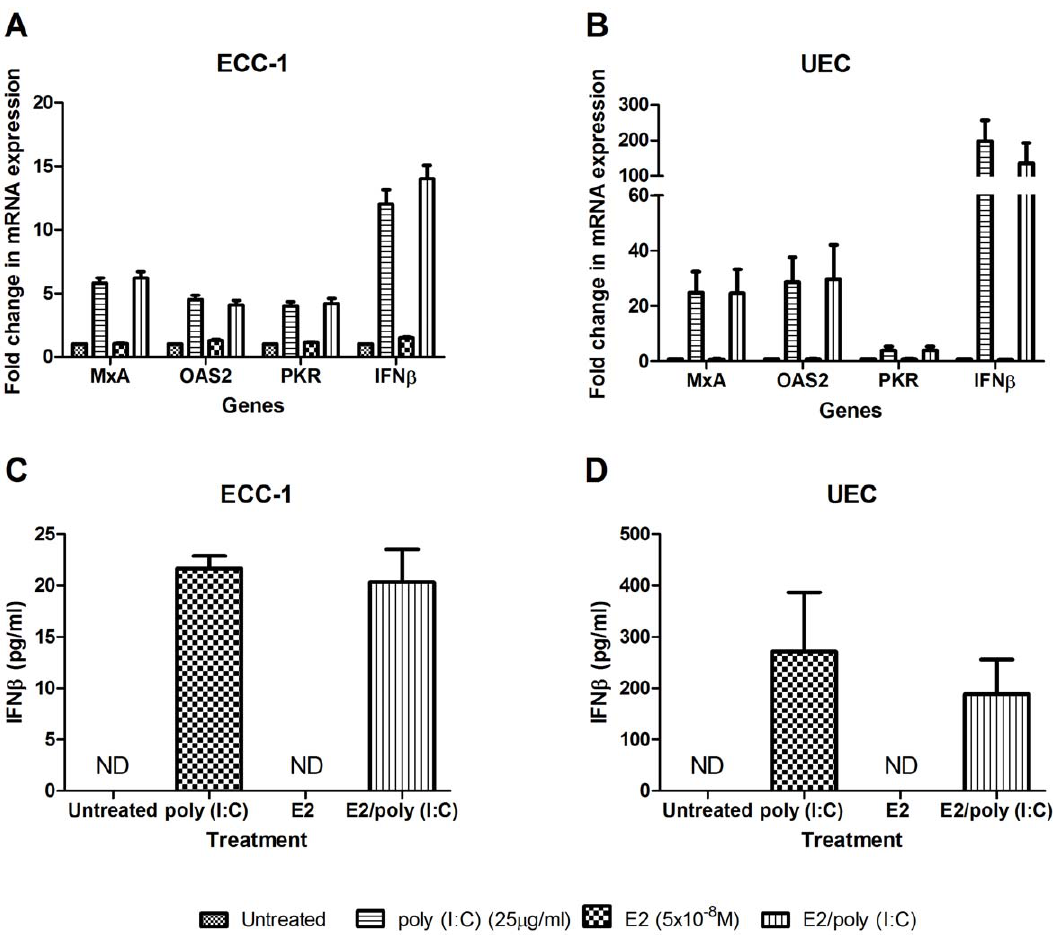
Figure 6. Estradiol has no effect on the poly (I:C)-mediated increase in IFN b , MxA, OAS2 and PKR. ECC-1 ( n=3 ) (a & c) and primary human UEC ( n=3 ) (b & d) were pretreated with estradiol (5 6 10 2 8 M) for 24 hours. Following media and hormone replenishment, poly (I:C) (25 m g/ ml) was added for 12 hours after which both cell culture conditioned media and mRNA were recovered and analyzed by ELISA (c & d) and RT-PCR (a & b) respectively. mRNA is expressed as a fold change over untreated samples (assigned a value of 1). Results are shown as the mean + / 2 SEM. ND=below the limit of detection of the ELISA assay.